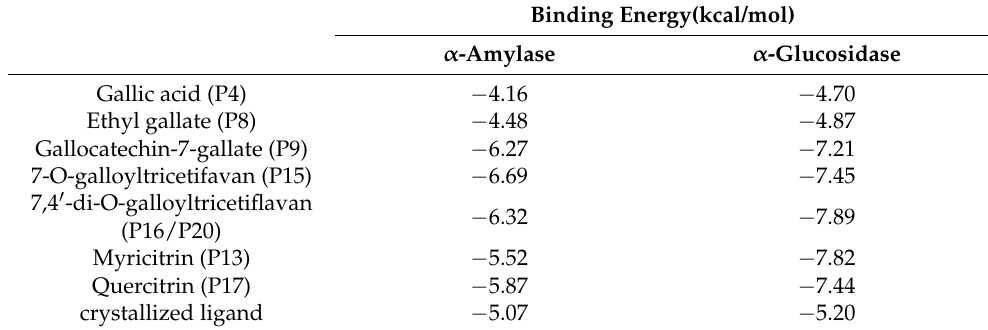
Table 6. Binding energy calculation